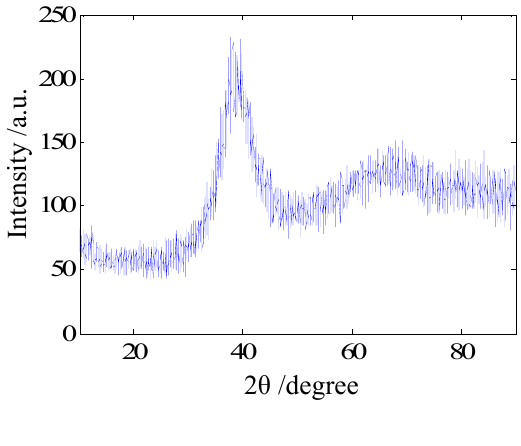
Cu Al Ti alloy. 46.5 45 7 1.5